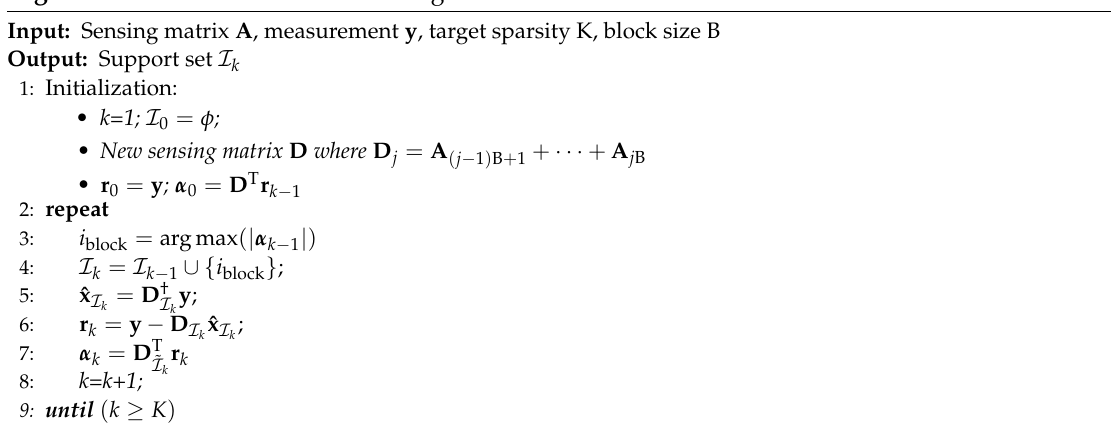
Algorithm 3 Block-Wise Estimation